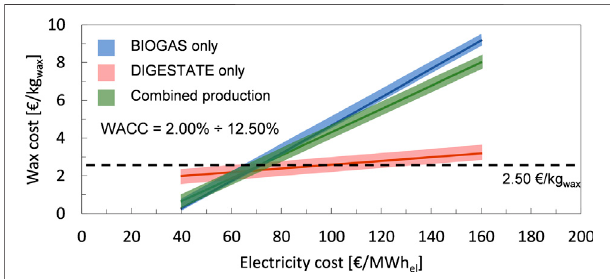
FIGURE8| Effectofparametervariationonthecostofwaxproductionin the location of Güstrow. Variation of the electricity cost and the WACC value: central lines of the color bands are evaluated at 7.50% WACC.